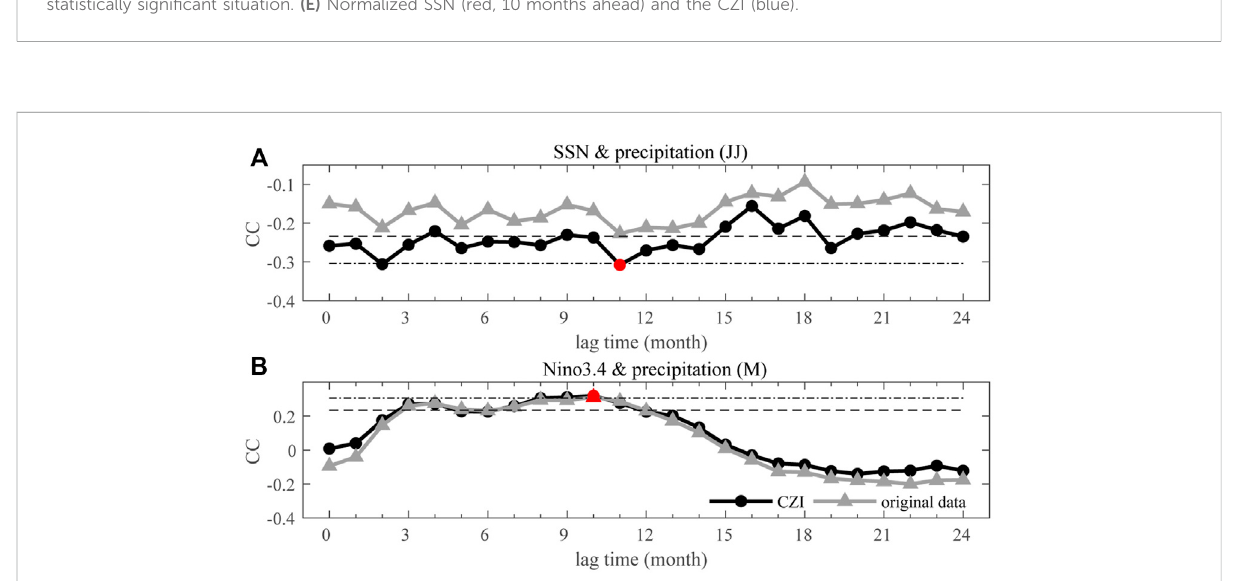
FIGURE 8 (A) Time-Lagged correlations between precipitation in June-July and SSN. (B) Precipitation in May and Niño 3.4. The gray curves with triangles denote correlations using the original precipitation data, and the black curves with circles denote correlations using the CZI. The black dashed (dot- dashed) lines denote the 95% (99%) con fi dence level. The red dots denote the most statistically signi fi cant